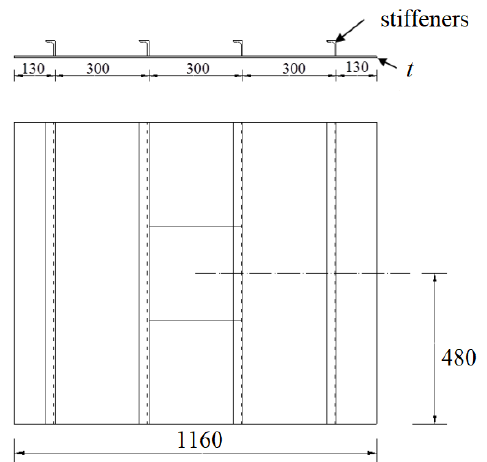
Figure 11. Simply supported stiffened plate with centered square hole (Adapted from [28]), in mm.